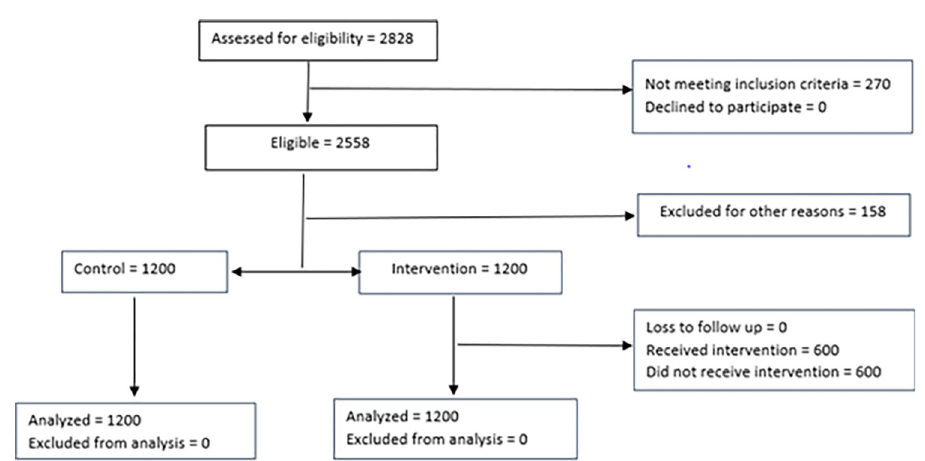
Fig 1. CONSORT flow diagram showing recruitment in intervention site (Dec 2018 –March 2019).